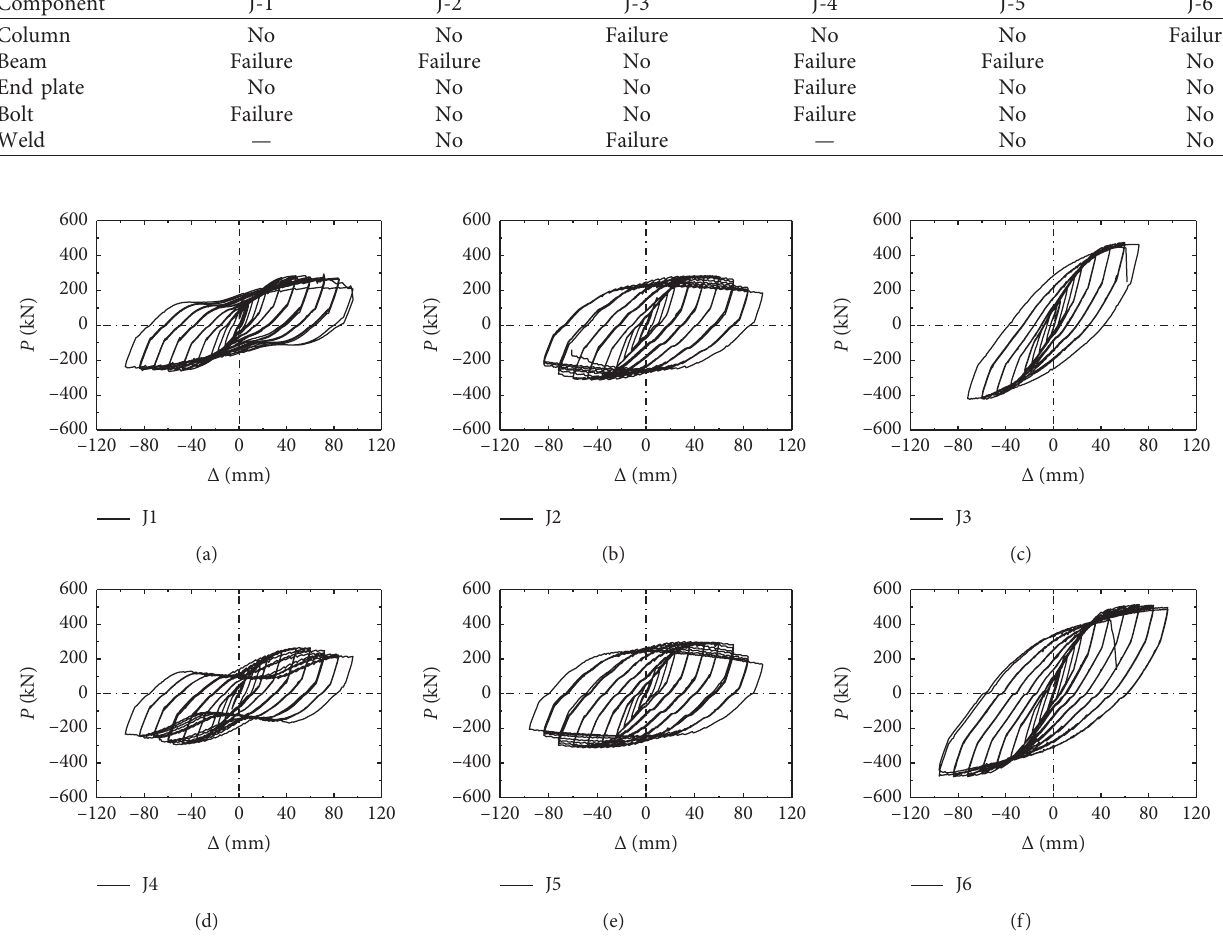
Figure 13: Load-displacement hysteretic curves of the joints: (a) J-1; (b) J-2; (c) J-3; (d) J-4; (e) J-5; (f)